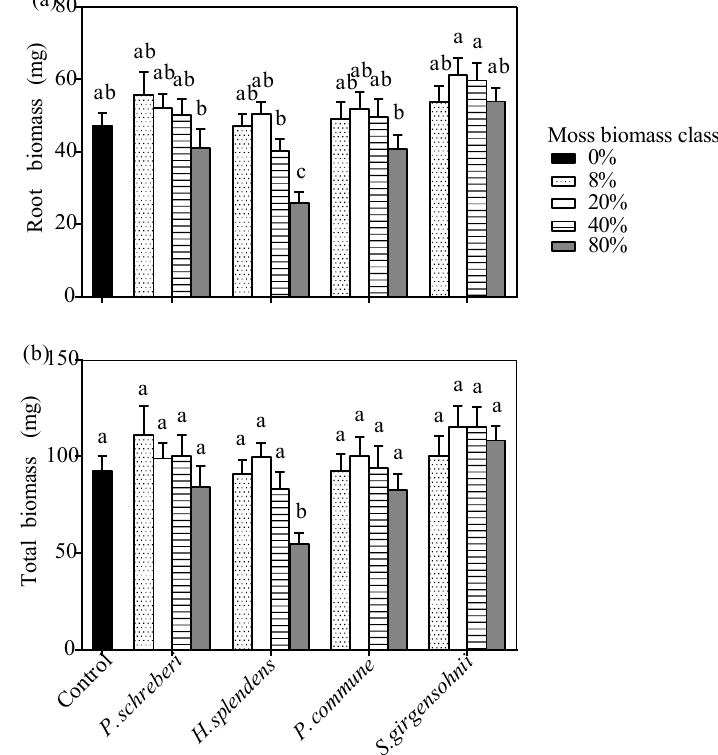
Figure 3. Response of Pinus sylvestris ( a ) seedling root biomass and ( b ) total seedling biomass across moss species and all moss biomass classes (MBC); bars show means + SE; significant differences are shown by different letters at p < 0.05 (Tukey’s HSD); ANOVA results are presented in Tables 1 and 2.